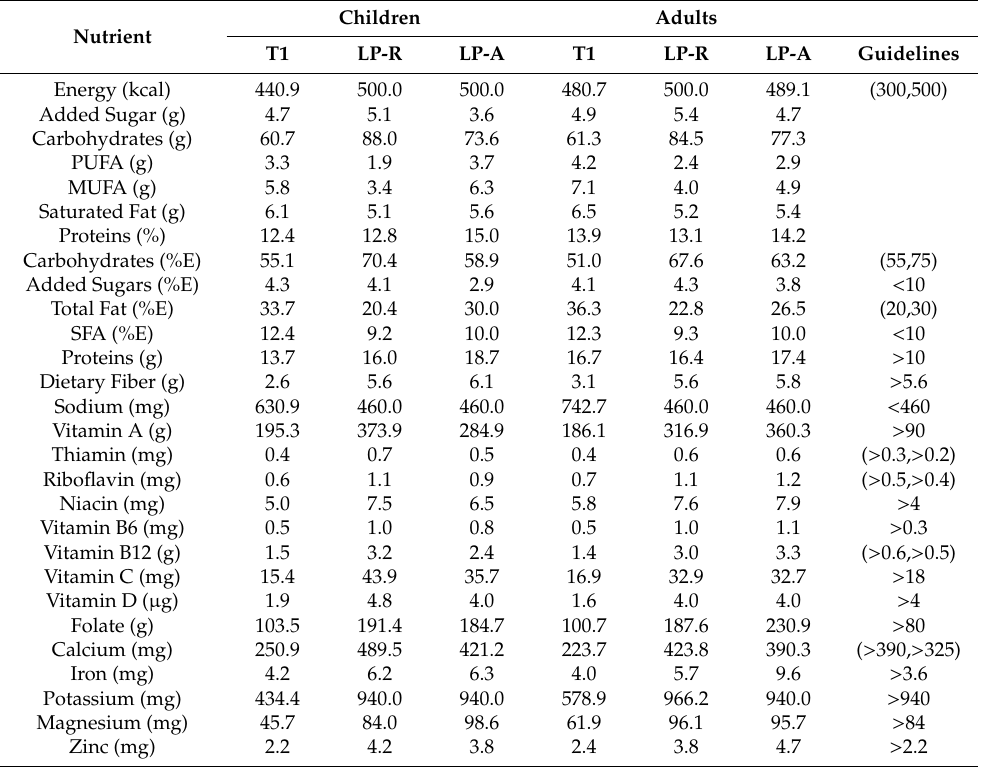
Table 3. Mean intake of nutrients at breakfast at T1 of the NRF 9.3 score and for optimized diets (absolute and relative